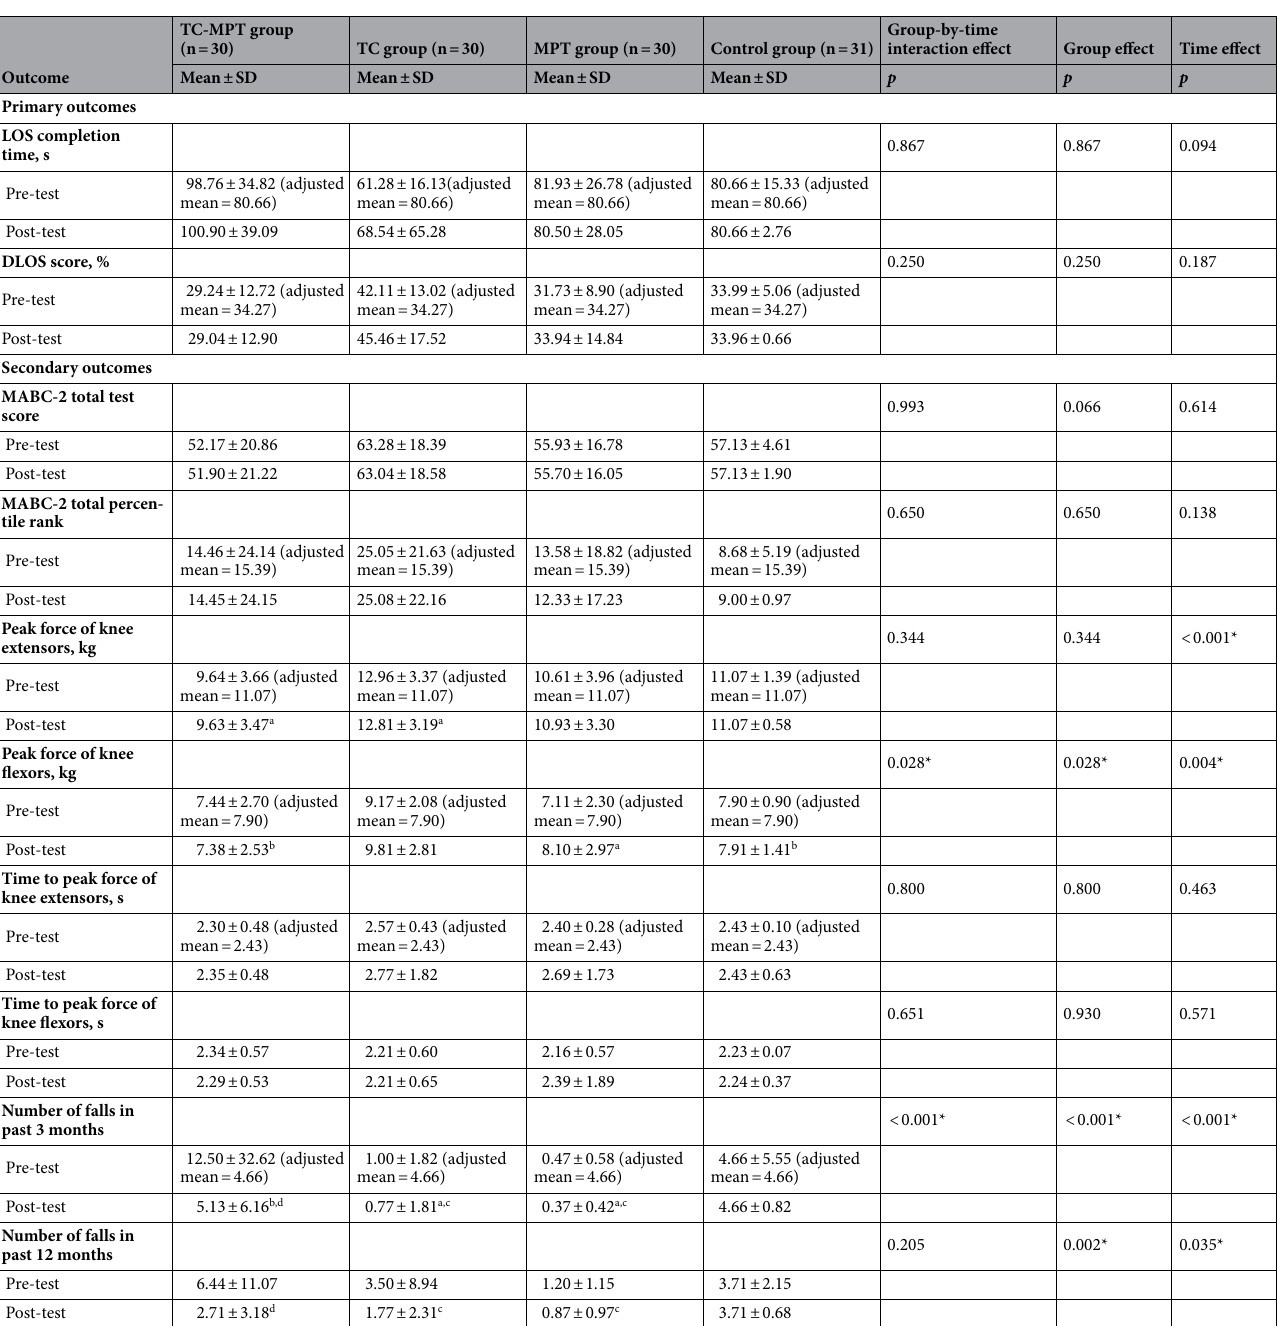
Table 2. Primary and secondary outcomes. All values are means ± standard deviations unless specified otherwise. Adjusted mean = mean adjusted for baseline differences. TC = tai chi, MPT = muscle power training, SD = standard deviation, LOS = limits of stability, DLOS = dynamic limits of stability, MABC-2 = Movement Assessment Battery for Children-Second Edition. * p < 0.05. Within-group differences: a p < 0.05 when compared with pre-test score. Between-group differences: b p < 0.0083 (Bonferroni-adjusted) when compared with the TC group at post-test. c p < 0.0083 (Bonferroni-adjusted) when compared with the control group at post-test. d p < 0.0083 (Bonferroni-adjusted) when compared with the MPT group at